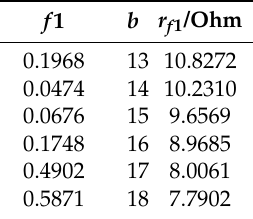
Table 4. Optimal solutions of f 1 when fault occurred at each node in set 1 for Case 1.